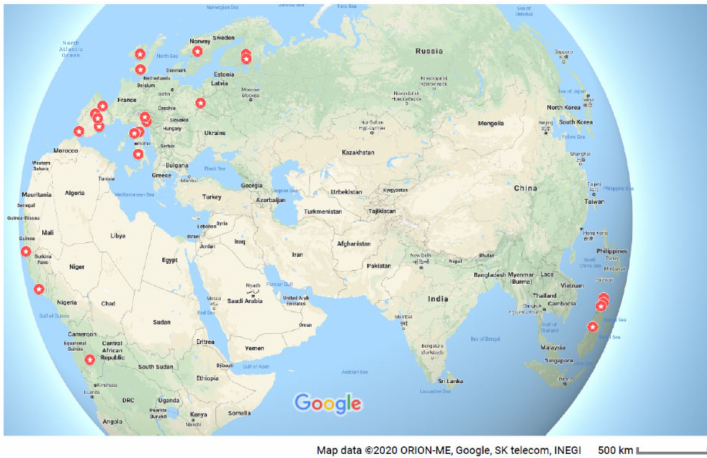
Figure 1. Distribution of the 27 datasets available in the GlobALS network (red